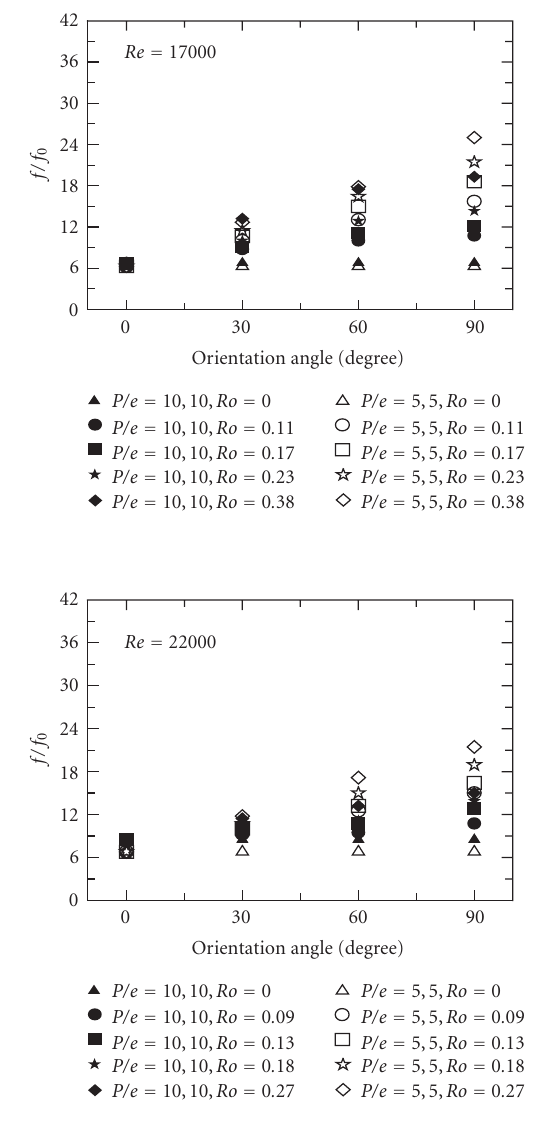
Figure 11: E ff ect of orientation angle in a rib-roughened square channel with attached ribs on two opposite walls (for comparison from Prabhu et al. [15]).